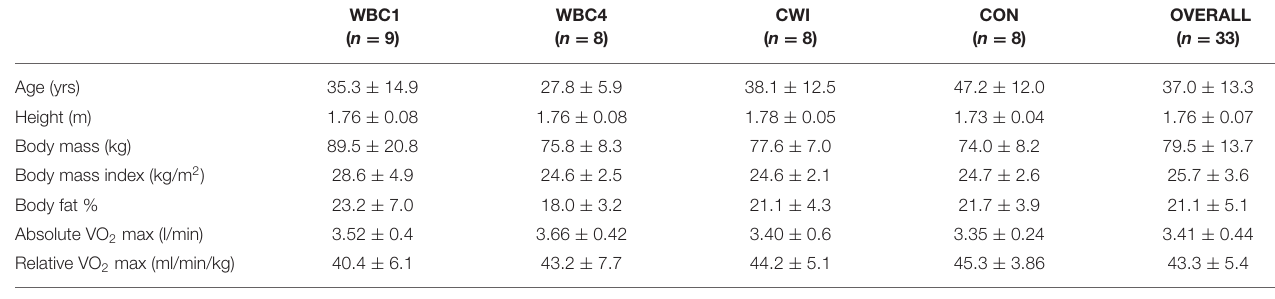
TABLE 1 | Summary of characteristics for whole body cryotherapy 1h (WBC1), 4h (WBC4), cold water immersion (CWI), and control (CON) participants.